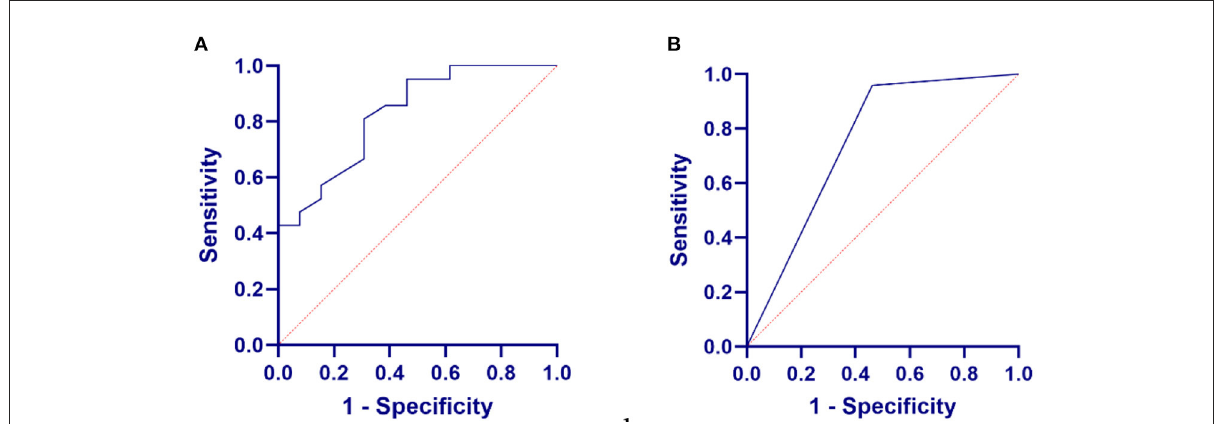
FIGURE3 Relationship between EHF pure-tone test or distortion product optoacoustic emission (DPOAE) in VM and SF hearing loss. (A) The relationship between the mean EHF hearing threshold in VM and SF hearing loss. (B) The relationship between the DPOAE in VM and SF hearing loss.